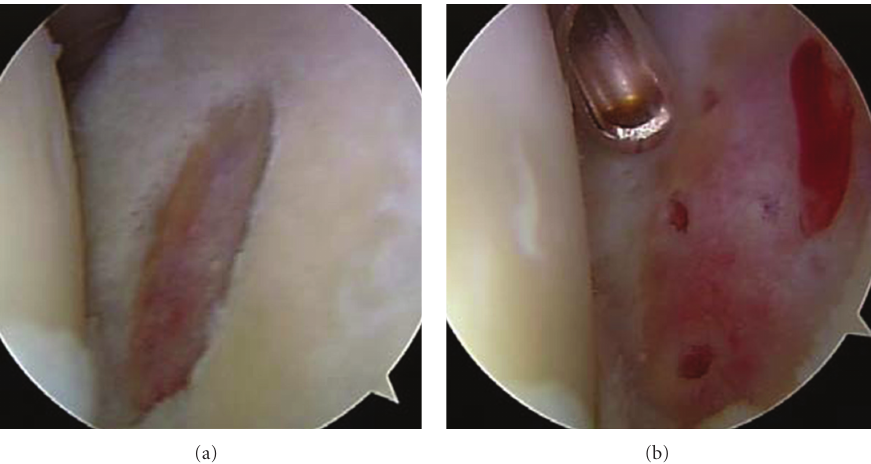
Figure 4: Arthroscopic images of preparation for (a) and result of (b) microfracture technique of a 2 × 2 cm glenoid lesion in a 65-year-old male.